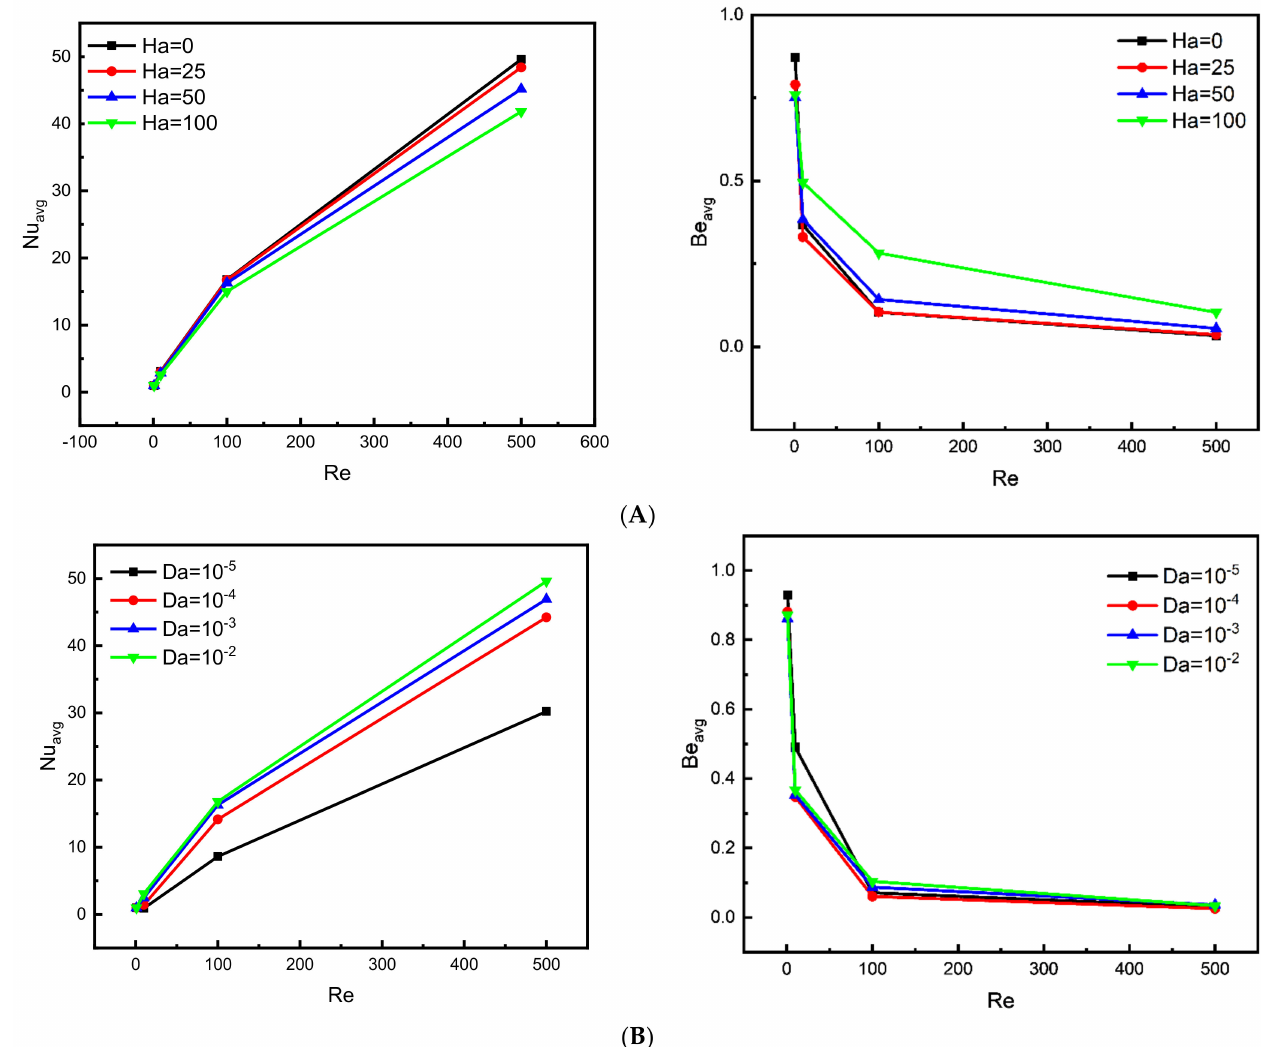
Figure 7. The mean Nusselt and Bejan (Be) development undergoing different values of Ha and Re for ϕ = 0.04 and Da = 0.01 ( A ), and undergoing different values of Da ( B ) and Re for ϕ = 0.04, Ha =